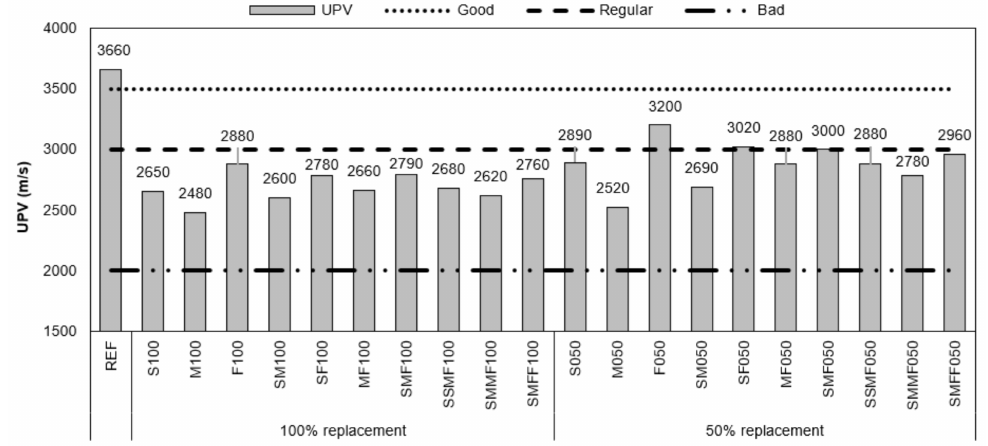
Figure 12. Results of the ultrasonic pulse velocity measurements in the